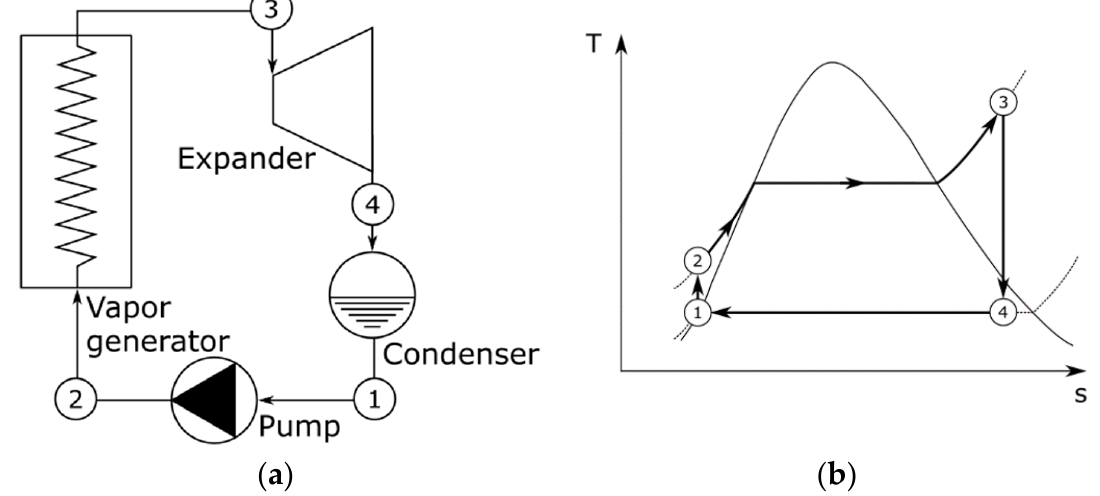
Figure 18. ( a ) Equipment and ( b ) T-s diagram of an ideal Organic Rakine cycle (ORC).